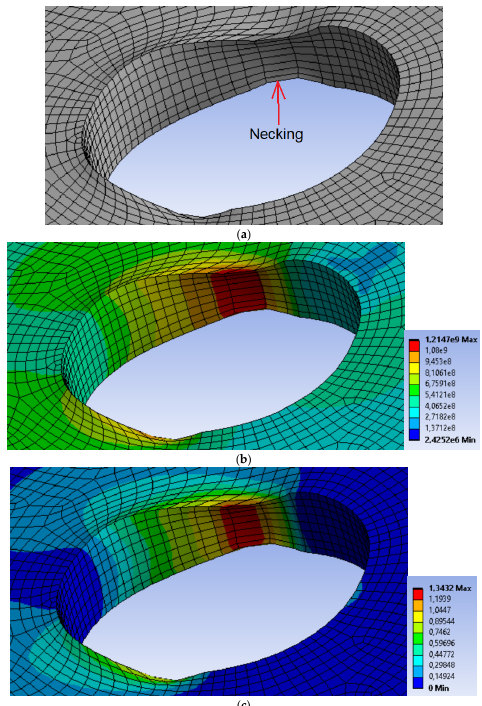
Figure 12. Deformed bolt hole of specimen T2 at tension fracture, ( a ) necking on a tension plane, ( b ) equivalent (von Mises) stress in Pa, ( c ) equivalent plastic strain in m/m.